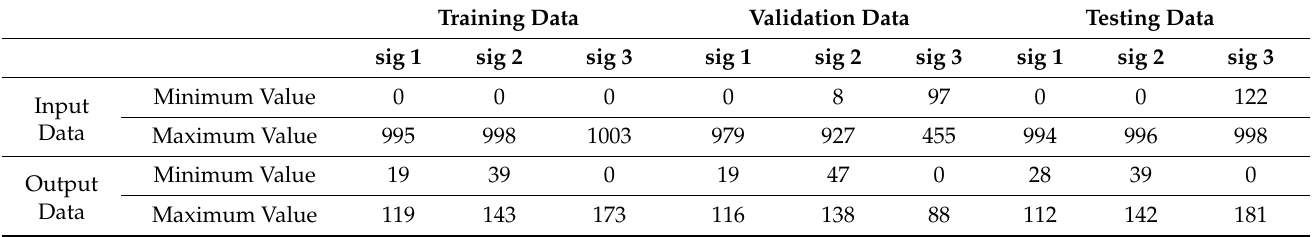
Table 6. Range of values for the input and output signals in each of the training, validation and testing datasets